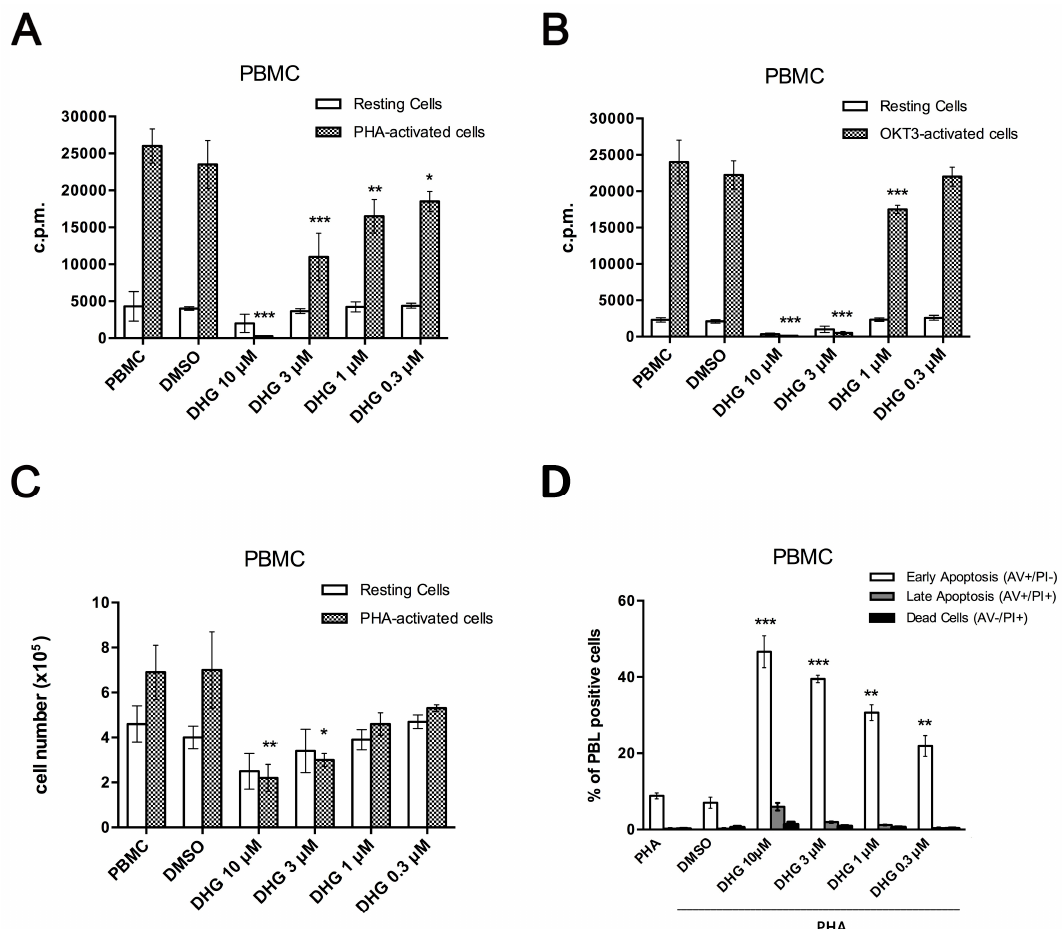
Figure 1. 9,11-Dihydrogracilin A (DHG) inhibits Peripheral Blood Mononuclear Cells (PBMC) proliferation and viability and induces apoptosis. ( A ) Unstimulated PBMC and phytohemagglutinin (PHA)-activated PBMC from healthy donors were treated with DHG at the indicated concentrations. Proliferation was measured after 18h of 3 H-thymidine incorporation (1 µ Ci). The counts per minutes (c.p.m.) ± the SD of the triplicates of five independent experiments are shown. (ANOVA * p < 0.05, *** p < 0.001, ** p < 0.01 versus PHA-treated PBMC); ( B ) Unstimulated PBMC and CD3 monoclonal antibody (OKT3)-activated PBMC of healthy donors were treated with DHG at the indicated concentrations. Proliferation was measured after 18h of 3 H-thymidine incorporation (1 µ Ci). The c.p.m. ± the SD of the triplicates of five independent experiments are shown. (ANOVA * p < 0.05, *** p < 0.001, ** p < 0.01 versus OKT3-treated PBMC); ( C ) Unstimulated PBMC and PHA-activated PBMC from healthy donors were treated with DHG, cultured for 6 days and stained with trypan blue. Cell viability was compared to that observed in PHA-activated PBMC (ANOVA * p < 0.05, ** p < 0.01). The histogram reported show the percent of live PBMC; ( D ) Induction of apoptosis was measured by annexin V and propidium iodide (PI) double staining through fluorescence-activated cell sorting (FACS) analysis in DHG-treated healthy donor PBMC, after 48 h. The panel reporting representative dot plots of 4 different experiments performed with similar results is included in the supplementary section (Supplementary Figure S1). Histograms in D indicate total percentage of early (Annexin V-positive cells/PI-negative cells) and late apoptotic events (Annexin V/PI-double positive cells) as well as necrotic cells (Annexin V-negative cells/PI-positive cells). Results are representative of 4 independent experiments and expressed as mean ± SD (ANOVA, *** p < 0.001, ** p < 0.01). DMSO, dimethyl sulfoxide.